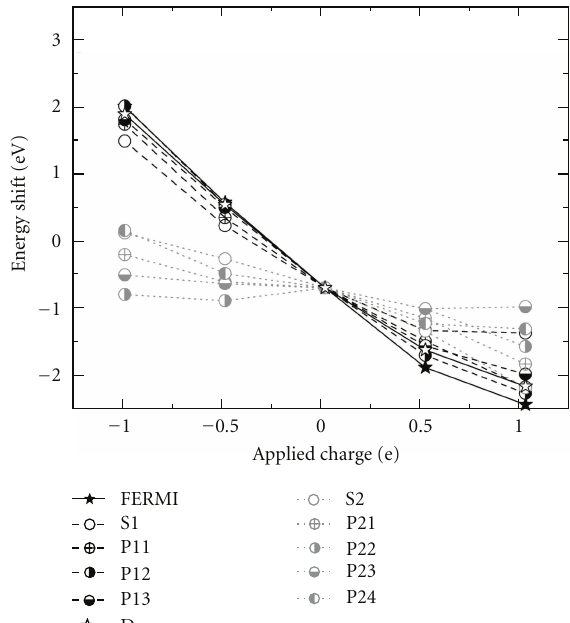
Figure 4: The shifts in energy of the Fermi level, copper d-band center (D), s and p bands of the oxygen of adsorbed OH (black symbols, dashed lines, S1, P11, P12, P13), and s and p bands of the oxygen of first-layer water molecules (gray symbols, dotted lines, S2, P21, P22, P23, P24) relative to the zero-charge values. Reproduced with permission from